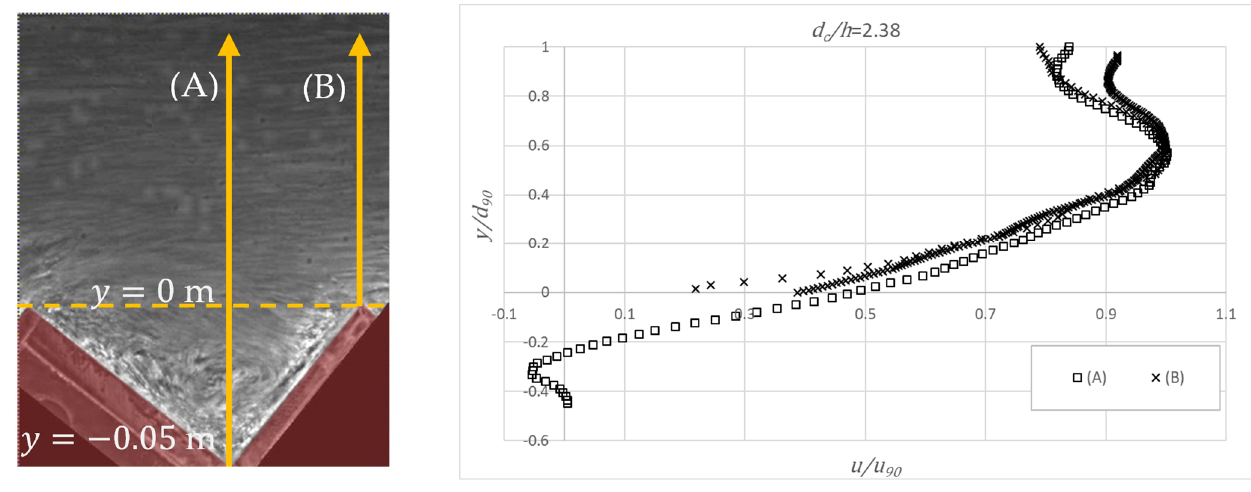
Figure 17. Dimensionless longitudinal ( u ) velocity profiles at L / L t = 0.49 for d c / h = 2.38, in the locations ( A ) and ( B ) for 400 fps. The scheme includes the layout of the verticals ( A ) and ( B ) where the velocities were obtained. The dashed line represents the pseudo−bottom (y = 0). Two different profiles in ( B ) position were obtained.